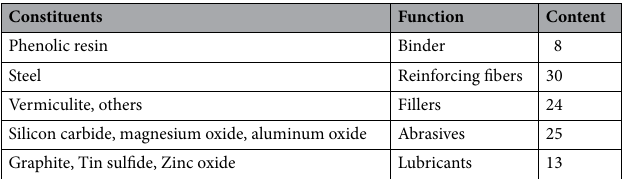
Table 1. Few constituents of the CFM with their respective function in (wt%) 18 .